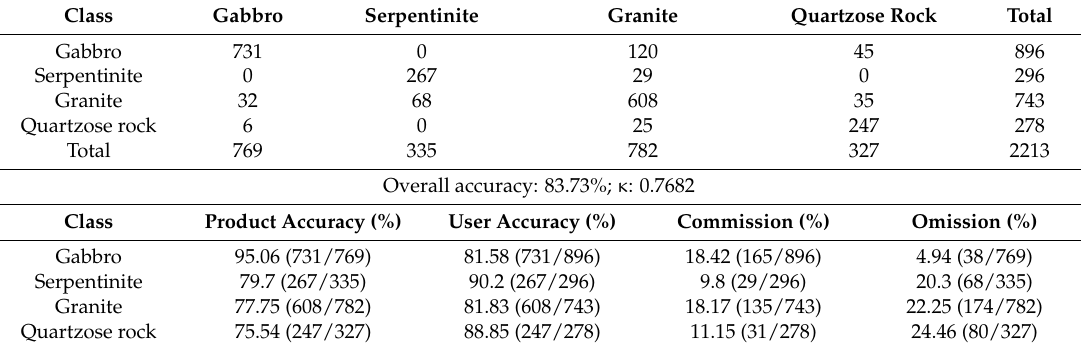
Table 5. Confusion matrix and accuracy evaluation of classification results using SVM with seven spectral vectors fused with seven textural